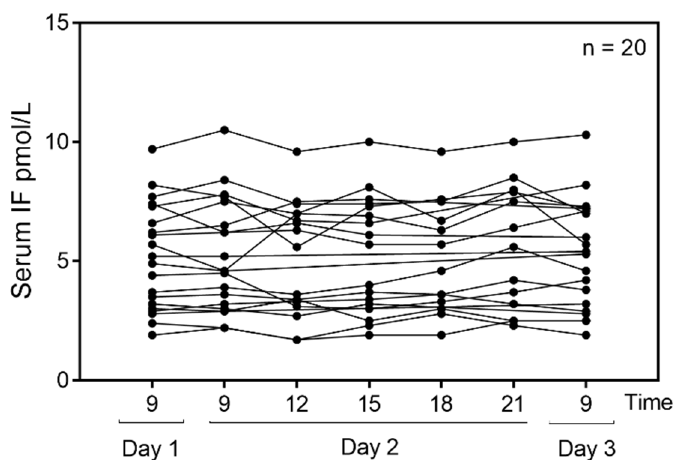
Figure 3. Diurnal variation of serum IF in healthy subjects. Serum IF was measured at different time points three days in a row in 20 healthy individuals. The 24-h clock format is used to indicate time of day. Out of 20 individuals, 13 donated blood at all time points and seven donated at some of the time points (all measures are shown in the figure). The RM-ANOVA was used to estimate differences in serum IF over time. No diurnal variation was found in this healthy cohort ( p = 0.2).